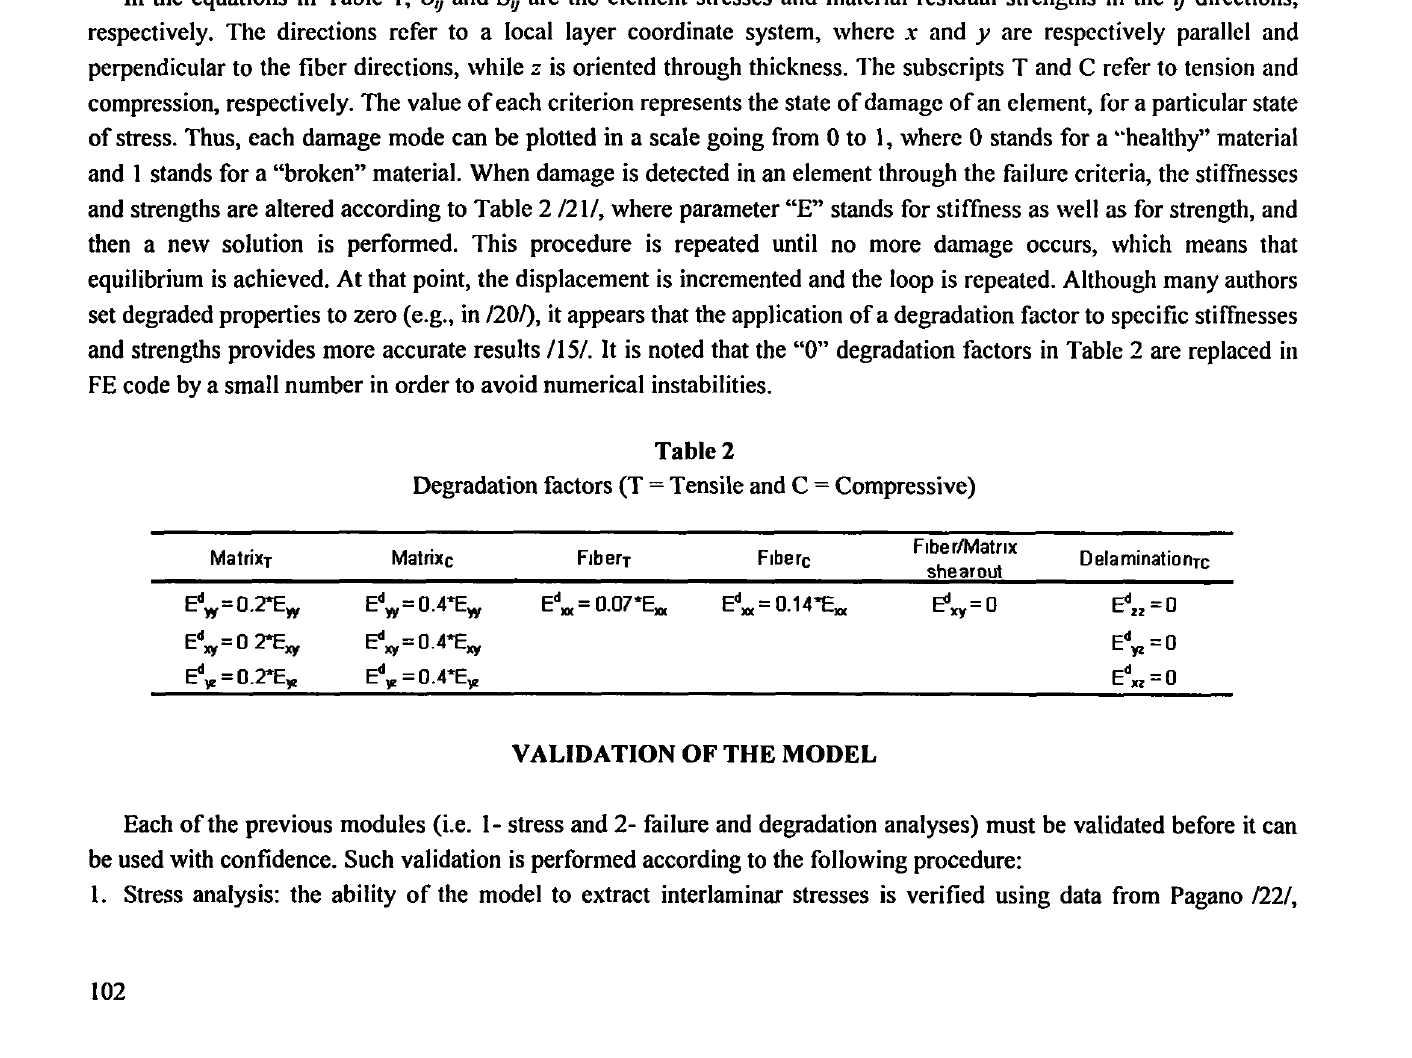
VALIDATION OF THE